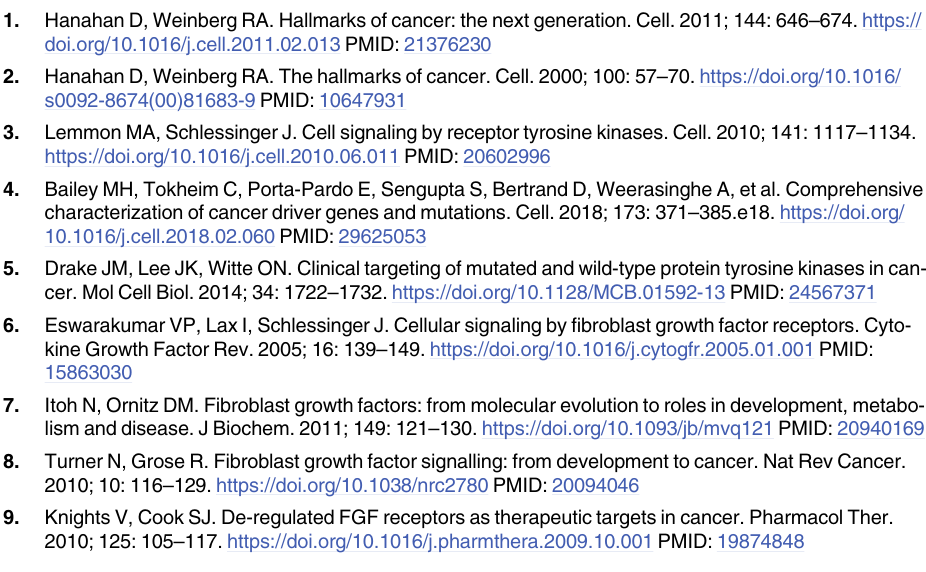
S6 Fig. Mean body weight over time in a CTG-0997 ( FGFR2-TRA2B Fusion Positive) cho- langiocarcinoma PDX